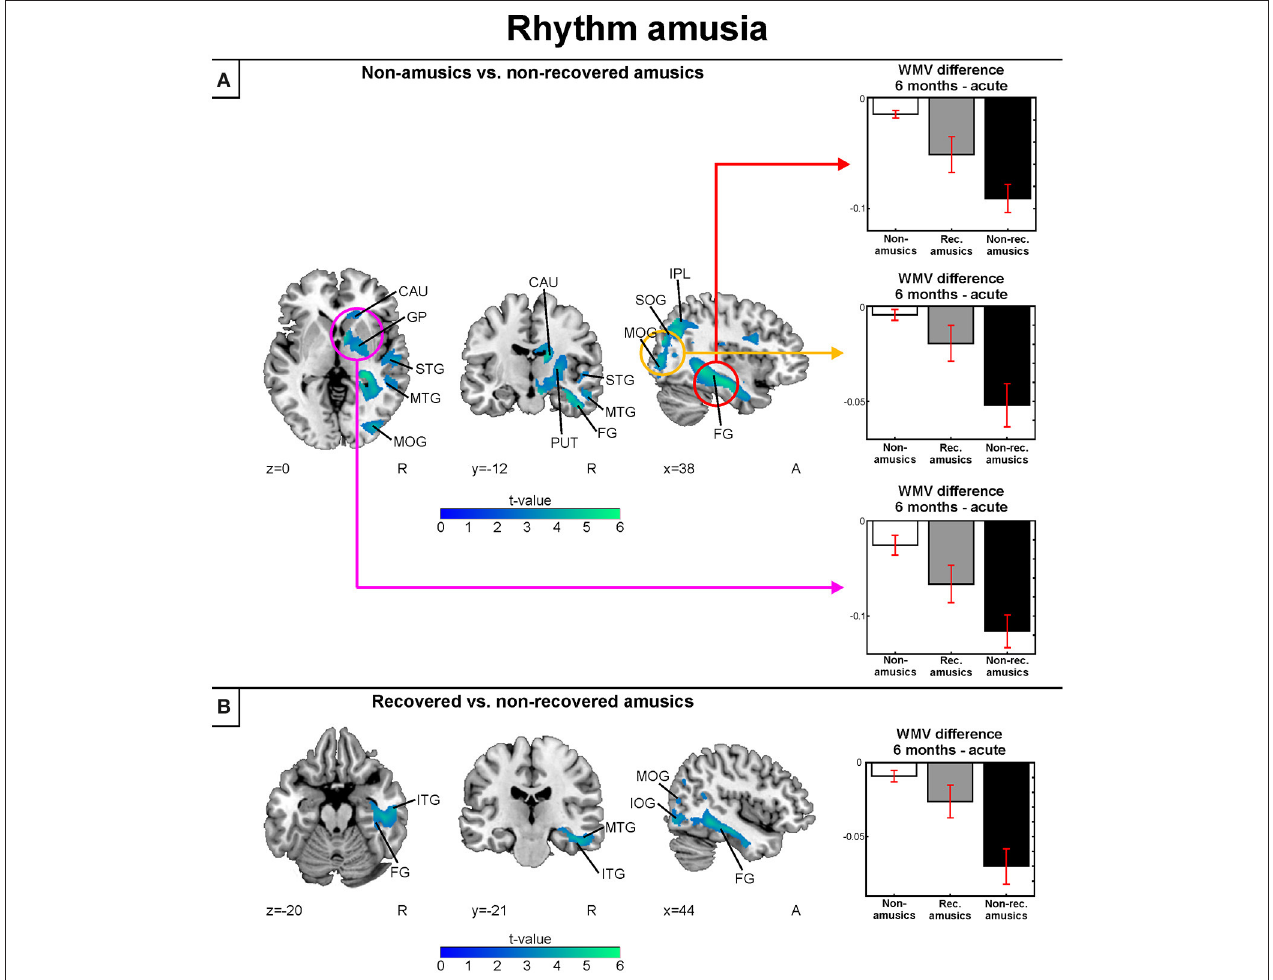
FIGURE 8 | White matter VBM results of pooled analysis: rhythm amusia. Time (6 months > Acute) × Group interactions for white matter volume. (A) Non-amusic vs. non-recovered amusics; (B) Recovered vs. non-recovered amusics. Results are thresholded at a whole-brain uncorrected p < 0.005 at the voxel level (extent threshold: k > 100 voxels) using MNI coordinates. Only clusters surviving an FWE-corrected p < 0.05 threshold are reported and labeled (see also Table 7 ). Bar plots for GMV differences in 6 months—Acute in significant clusters ( Table 7 ) are shown: bar = mean, error-bar = standard error of the mean. CAU, Caudate; FG,